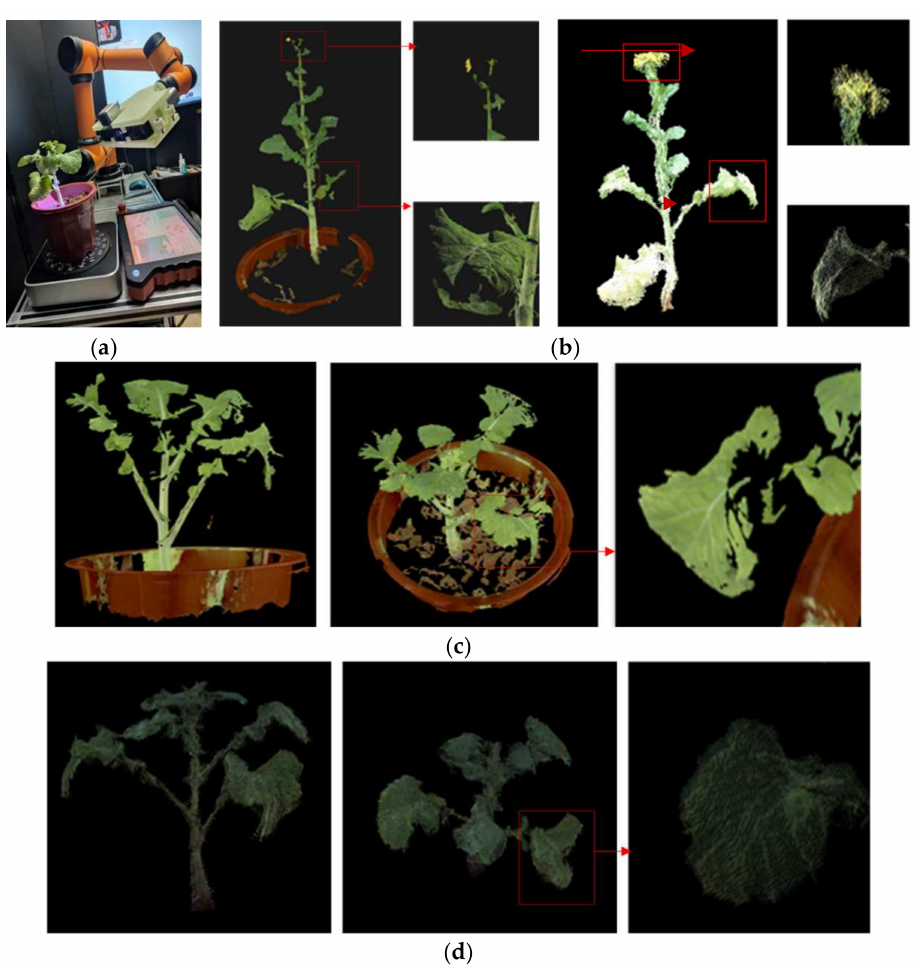
Figure 13. Comparison of the 3D reconstruction effect between the laser scanner and the algorithm in this paper. ( a ) 3D reconstruction of laser scanner (flowering rapeseed). ( b ) 3D reconstruction of our method using the same sample. ( c ) Another 3D Reconstruction of 3D laser scanner (Rapeseed in moss stage). ( d ) 3D reconstruction of our method using the same